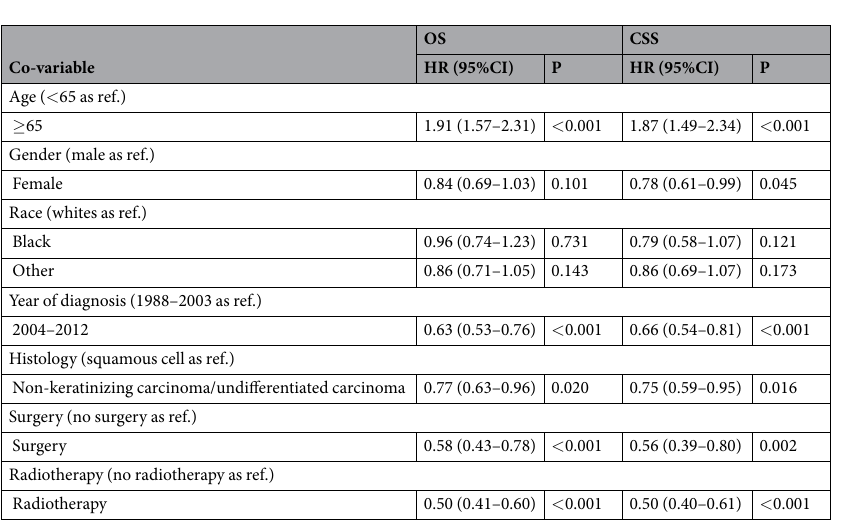
Table 5. Weighted multivariate analyses using IPTW by